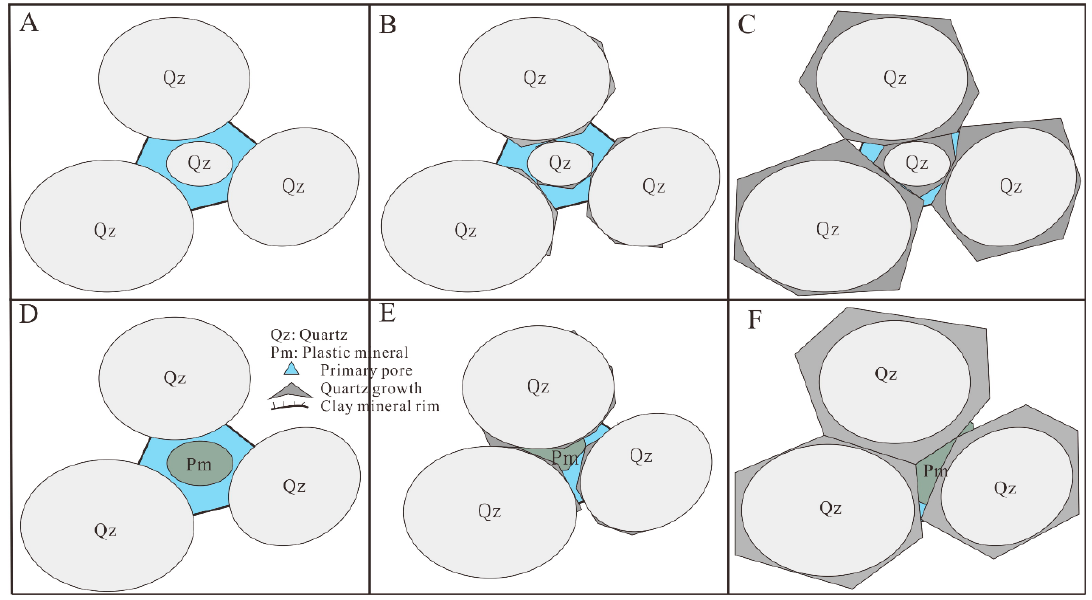
Figure 11. Diagram of the evolution pattern of pores between quartz grains and primary grains. ( A ) the primary intergranular pore between quartz grain during early diagenetic stage; ( B ) the primary intergranular pore between quartz grain which developed a layer of micron quartz during early-middle diagenetic stage; ( C ) the primary intergranular pore between quartz grain which developed to the hexagonal dipyramid grain during late diagenetic stage; ( D ) the primary intergranular pore of lithic quartz sandstone during early diagenetic stage; ( E ) the primary intergranular pore of lithic quartz sandstone where quartz developed a layer of micron quartz and some of the intergranular pore filled by the rock fragments or fake matrix during early-middle diagenetic stage; ( F ) the primary intergranular pore of lithic quartz sandstone where quartz grain which developed to the hexagonal dipyramid grain during late diagenetic stage.